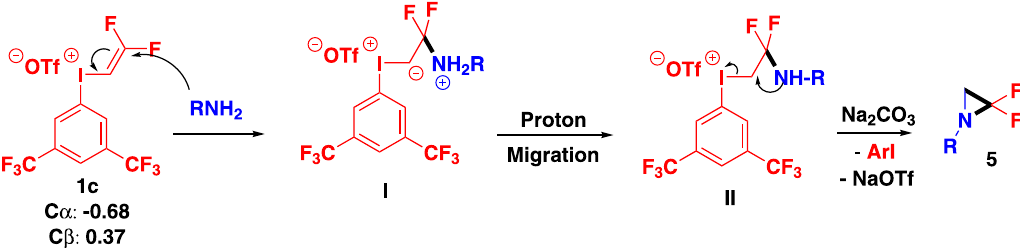
Fig. 9 Proposed reaction mechanism for the formation of aziridines iodonium yield. The reaction proceeds via iodonium yield